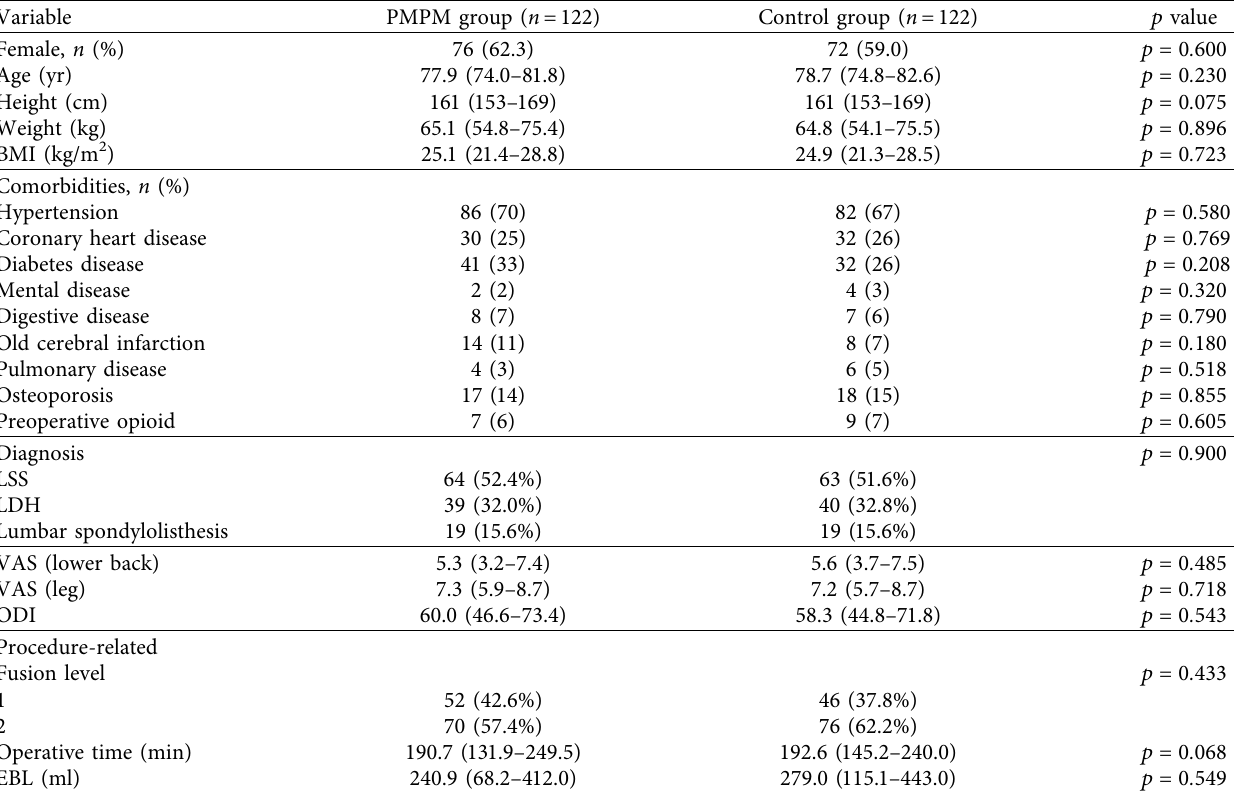
Table 2: Baseline characteristics of patients in the two groups.